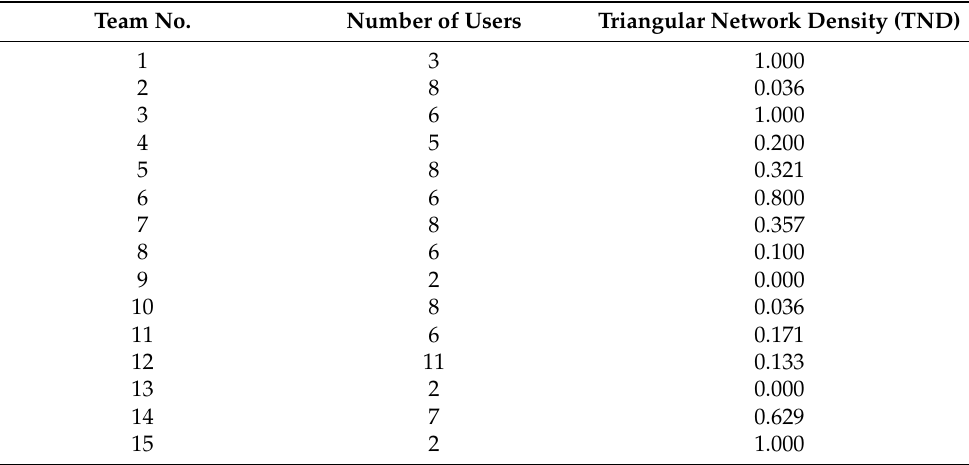
Table 4. Triangular network density for each team. Team